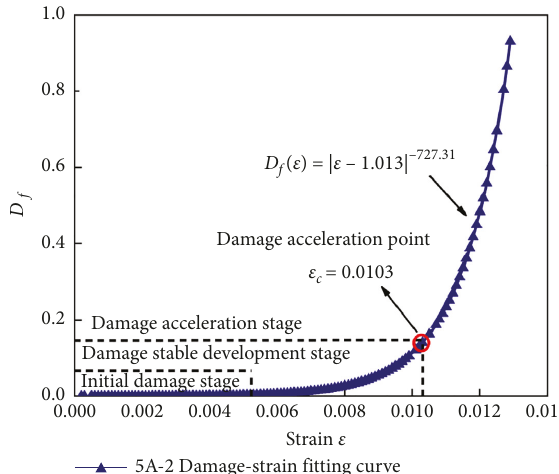
Figure 17: Damage-strain curve of 5A-2.